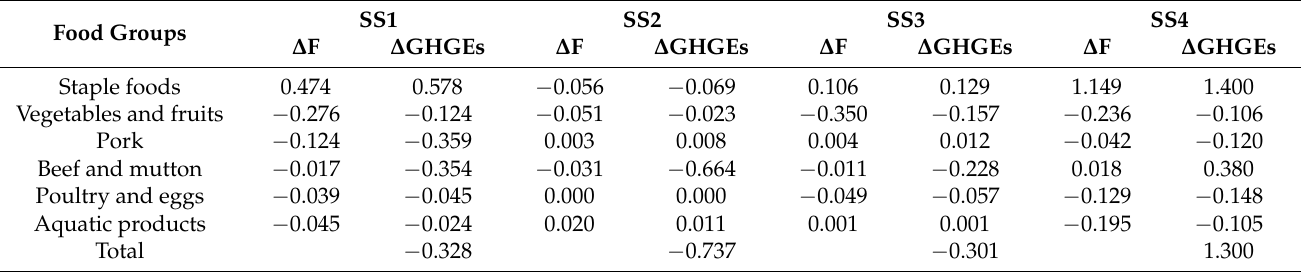
Table 7. The projected impacts of a rise in animal-based food prices on food demands and GHGEs